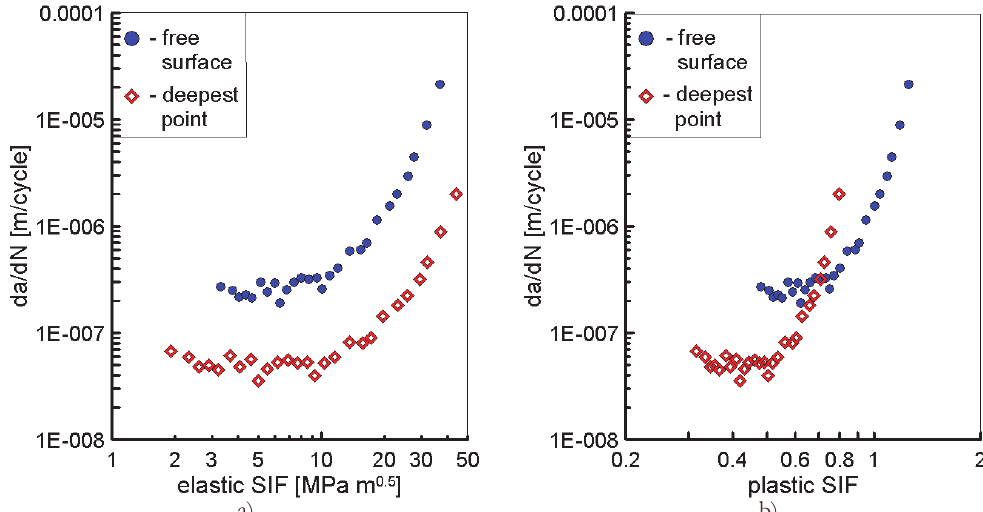
Figure 12: Crack growth rate as a function of (a) elastic and (b) plastic SIFs under bending for different crack front